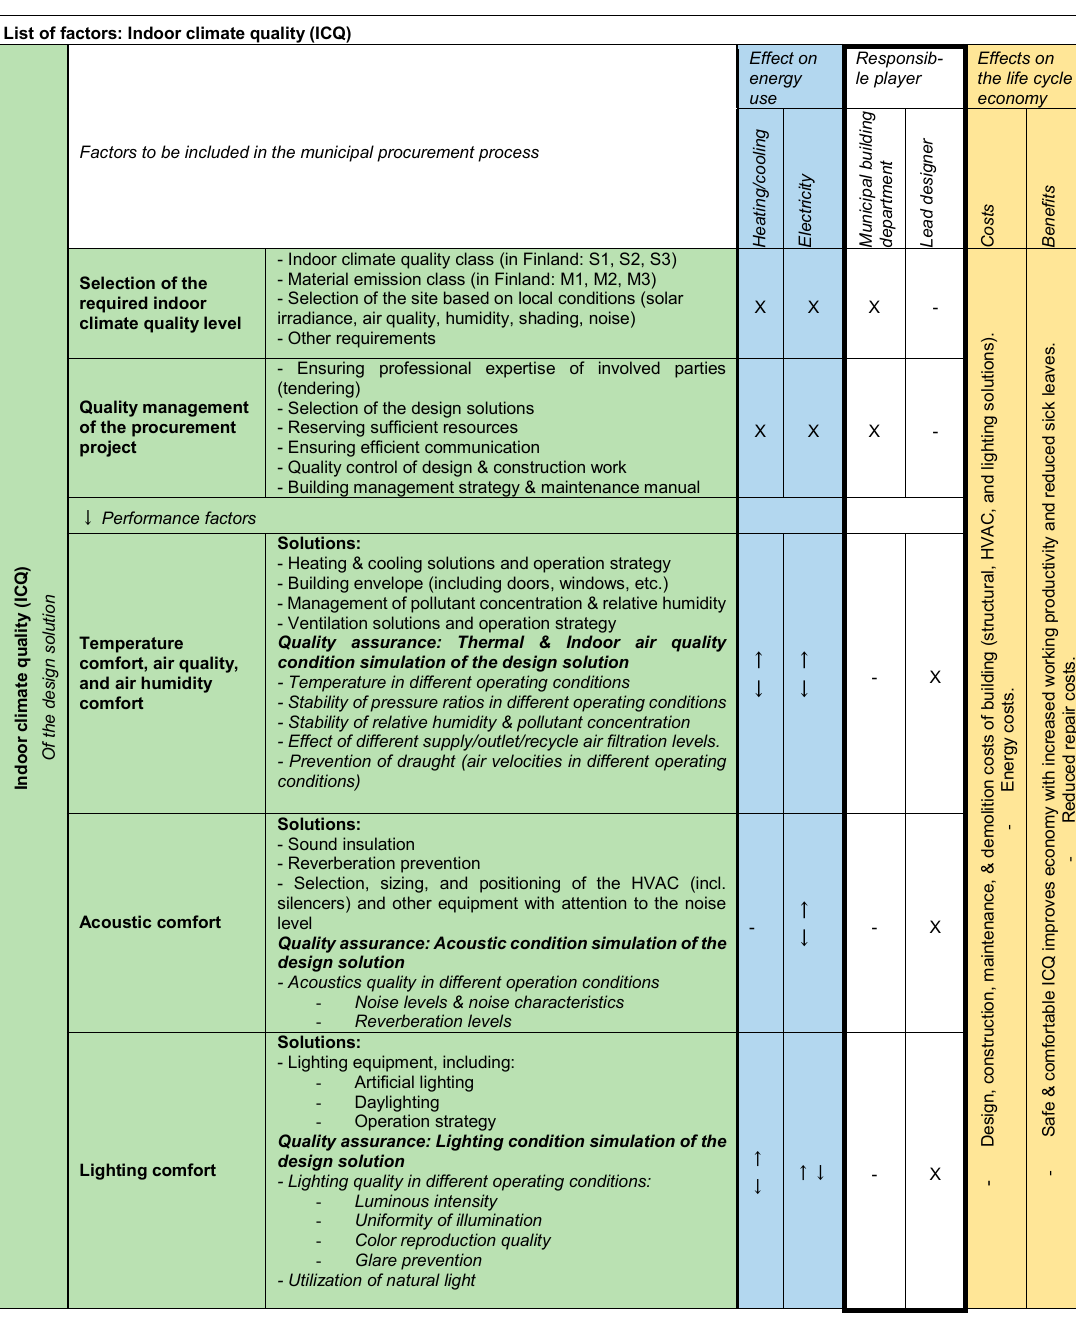
Figure 8. The energy efficiency responsibilities in the design of the municipal building: Indoor climate quality. Based on [10–14,36,41,43,46,47,69,73,74,78–80,82–85].